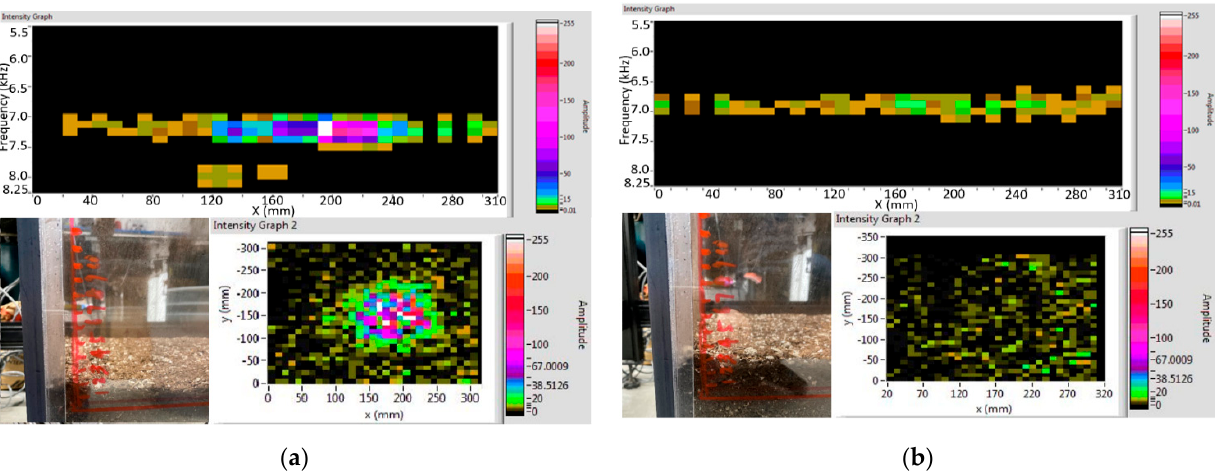
Figure 13. W–band underground imaging experimental results ( a ) under 1.5 cm-thick soil, ( b ) under 3 cm-thick soil.